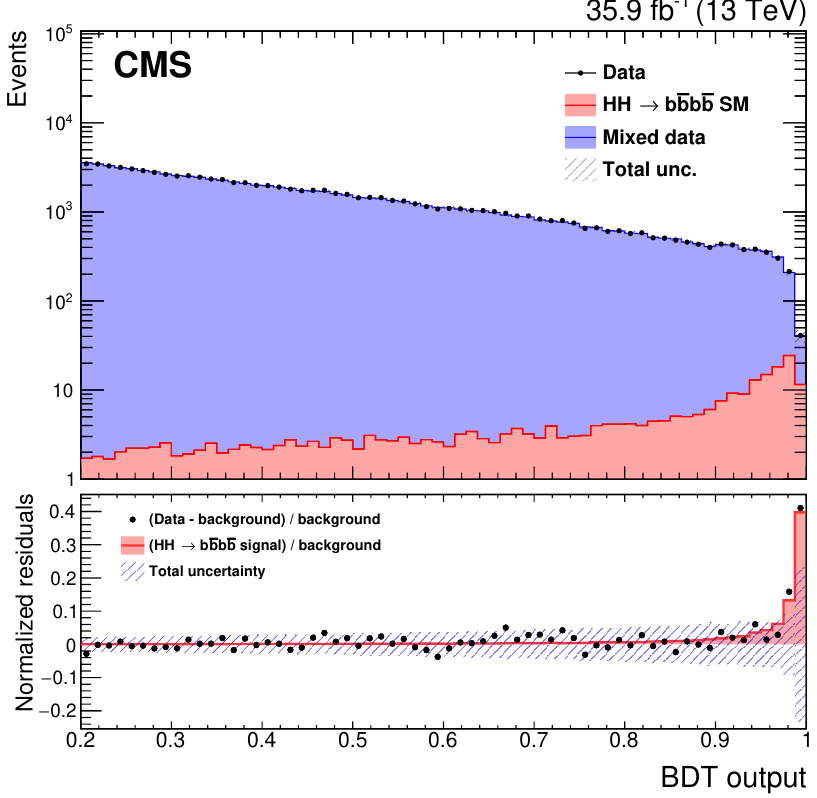
Figure 7 . Results of the (cid:12)t to the BDT distribution for the SM HH production signal. In the bottom panel a comparison is shown between the best (cid:12)t signal and best (cid:12)t background subtracted from measured data. The band, centred at zero, shows the total